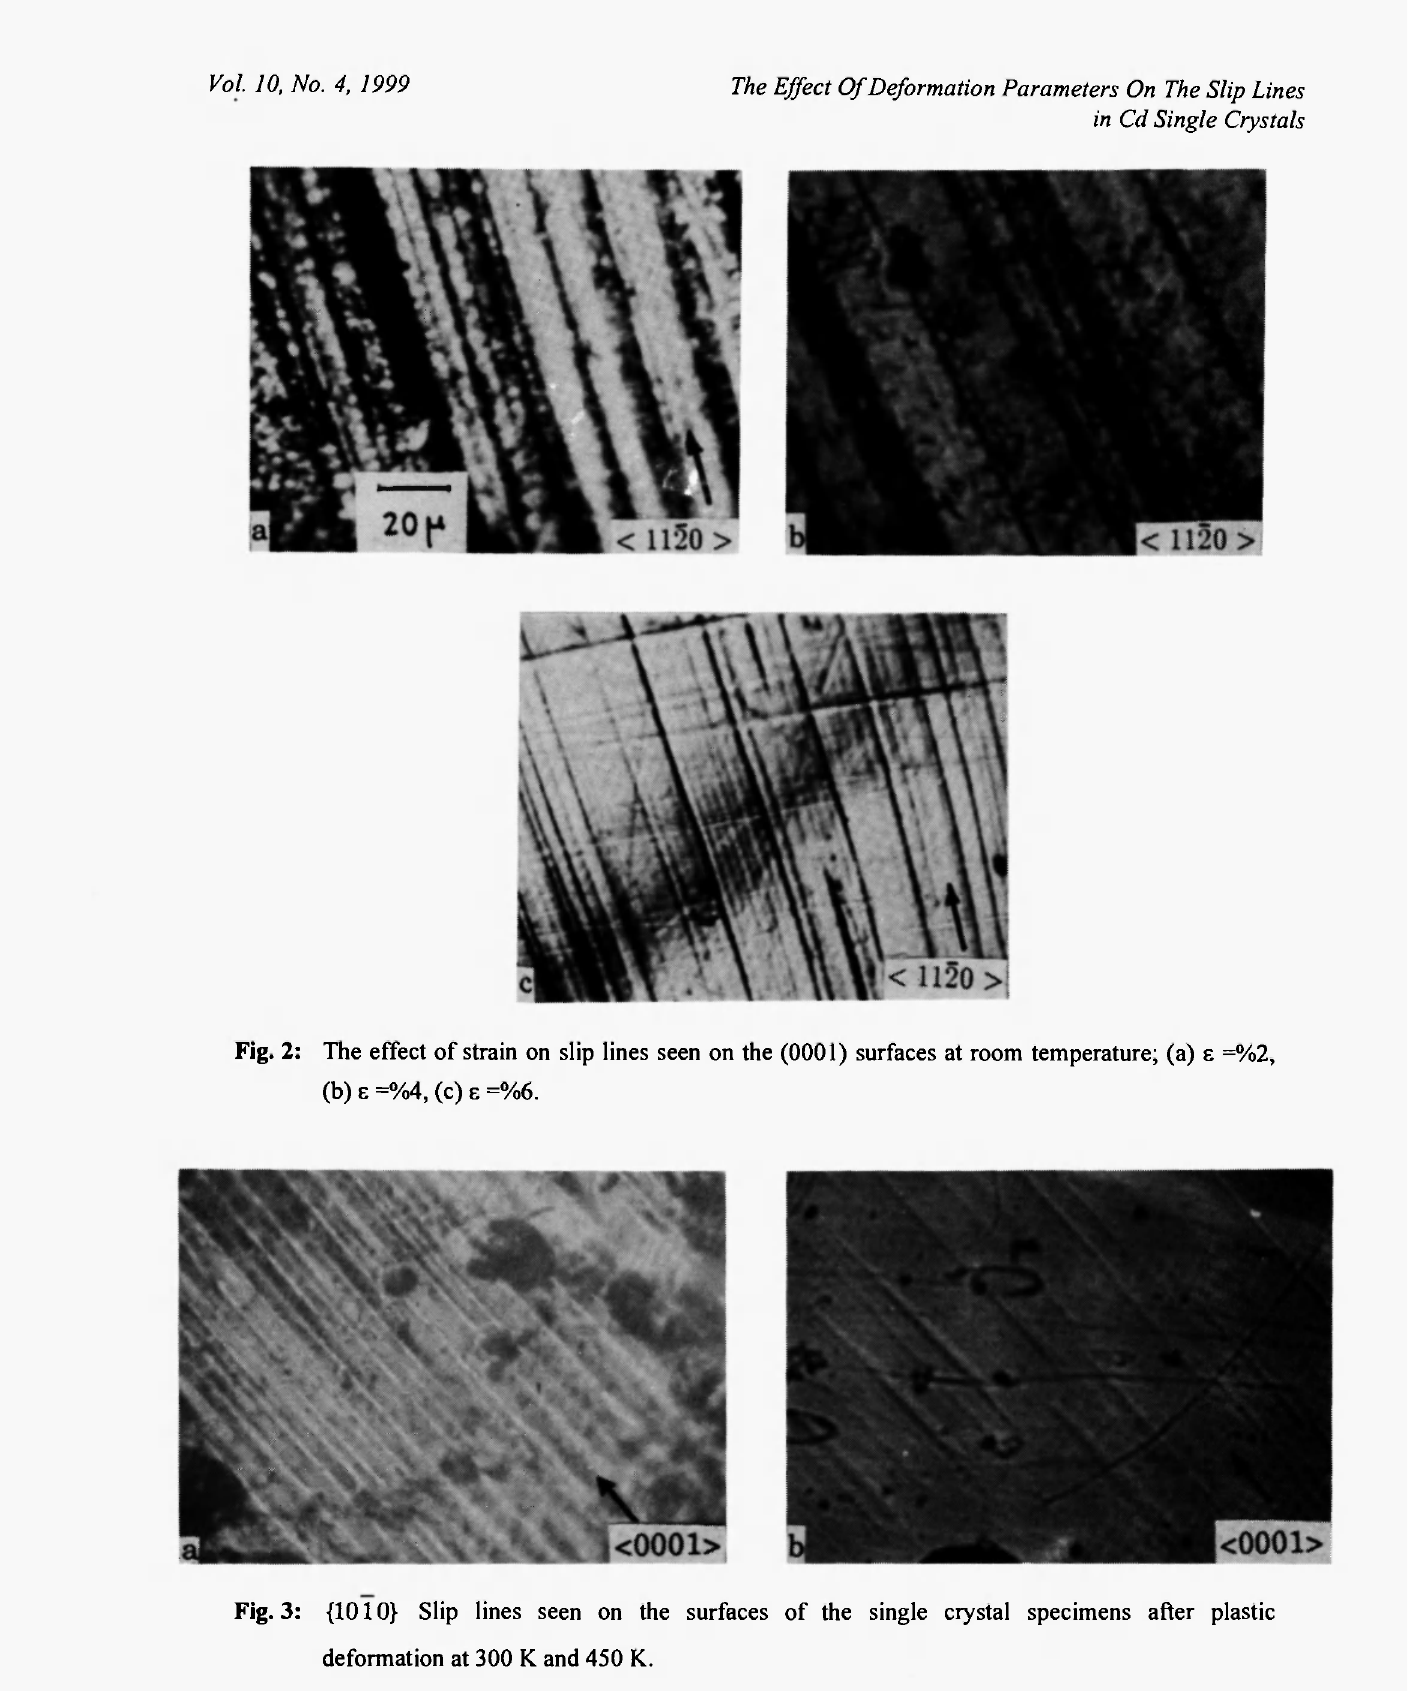
Fig. 3: {1010} Slip lines seen on the surfaces of the single crystal specimens after plastic deformation at 300 Κ and 450